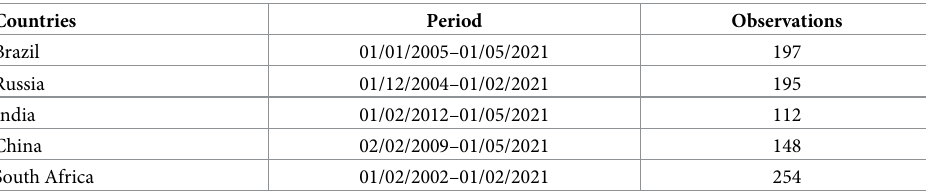
Table 1. Summary of sample